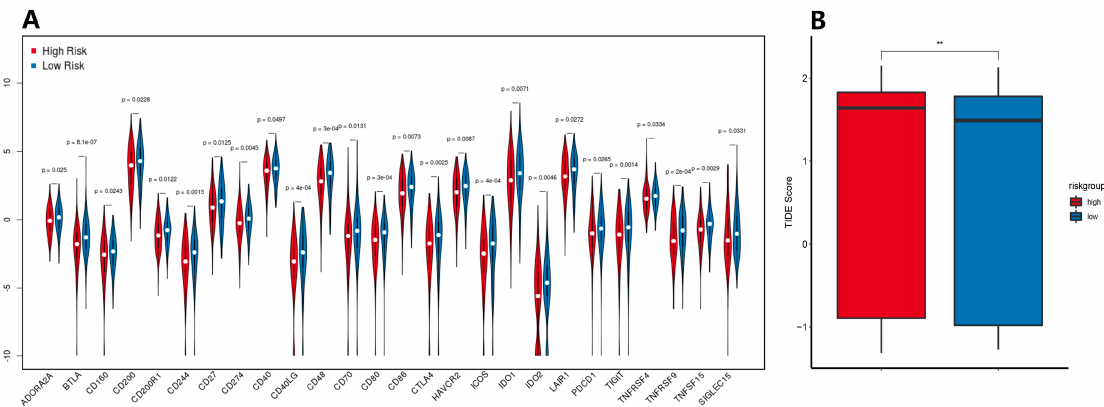
Figure 9. ( A ) Expression levels of immune checkpoint genes in the low- and high-risk groups. ( B ) Tumor Immune Dysfunction and Exclusion (TIDE) score in the low- and high-risk groups. ** p <